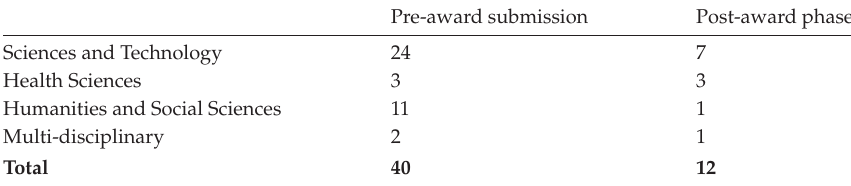
Table 1: Disciplinary distribution of projects supported (1 st of December